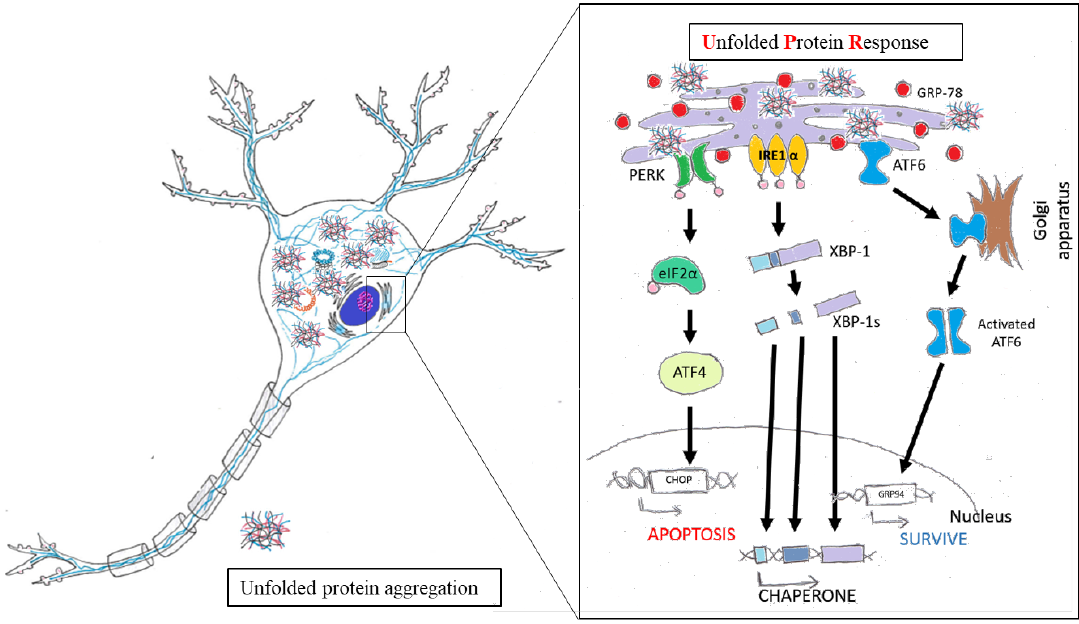
Figure 3. Schematic representation of the unfolded protein response pathway.